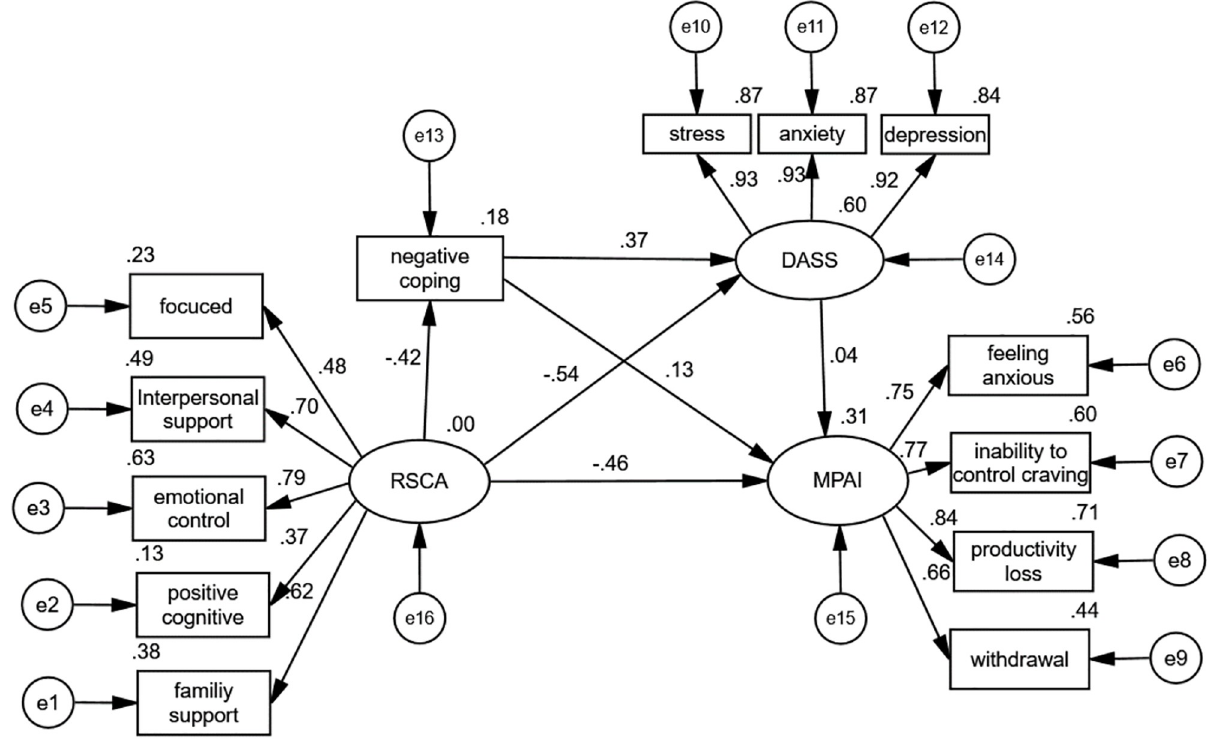
Fig 2. The standardized path coefficients in model